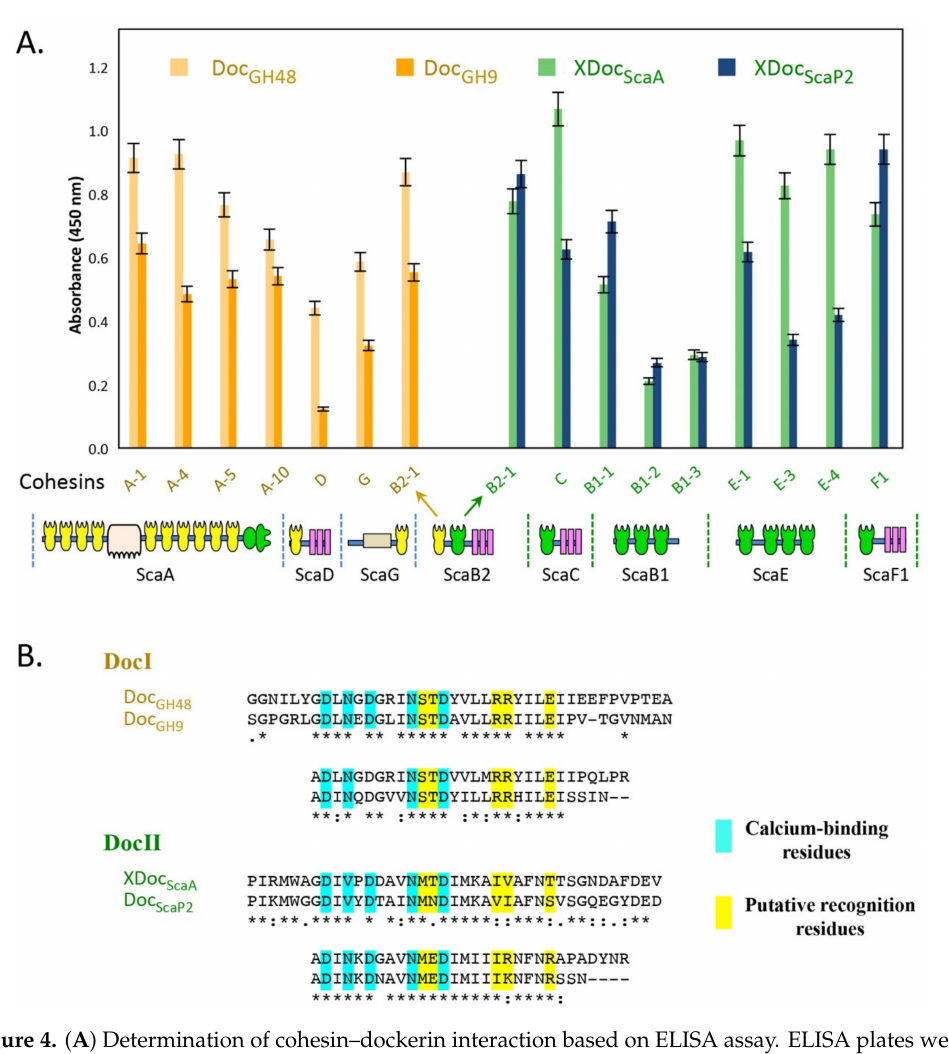
Figure 4. ( A ) Determination of cohesin–dockerin interaction based on ELISA assay. ELISA plates were coated with the designated XynDoc fusion proteins at a concentration of 1 µ g / mL, and the indicated Coh constructs were examined at a reference concentration of 100 ng / mL. Cohesin A-1, A-4, and A5 indicate the first, fourth, and fifth cohesin in sca ff oldin ScaA. The other cohesins in the figure are named similarly. See Figure 1 for description of the sca ff oldins. ( B ) Type I and type II dockerin sequences used in this